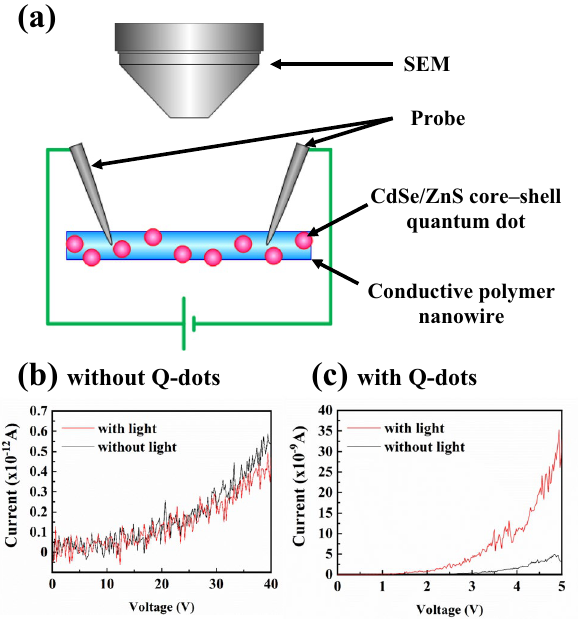
Figure 3. ( a ) The measuring process of a CPNW conductivity using a SEM-based nano-probe system. ( b ) I – V curves of the CPNWs without QDs in the presence and absence of light irradiation, ( c ) with QDs.